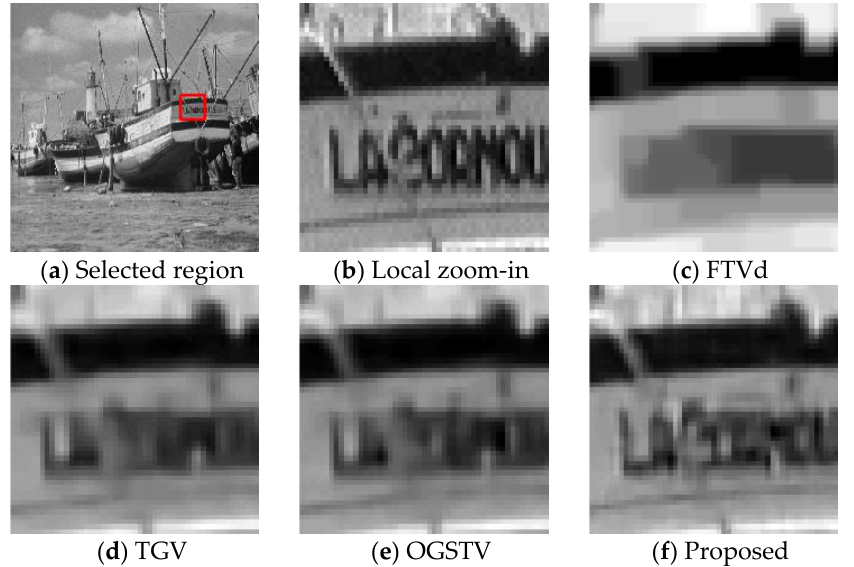
Figure 7. Local zoomed-in images from Figure 6 for better comparison: ( a ) selected region of the original image; ( b ) local zoomed-in image of the selected region; ( c ) FTVd-restored image; ( d ) TGV-restored image; ( e ) OGSTV-restored image; ( f ) proposed algorithm-restored image.